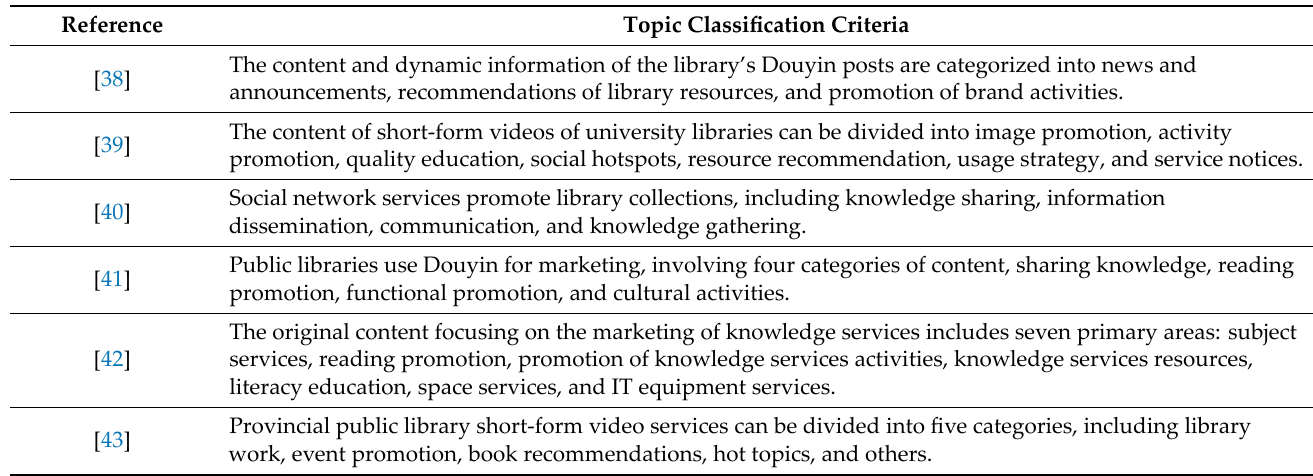
Table 1. Selected literature about video topic classification criteria. Topic Classification